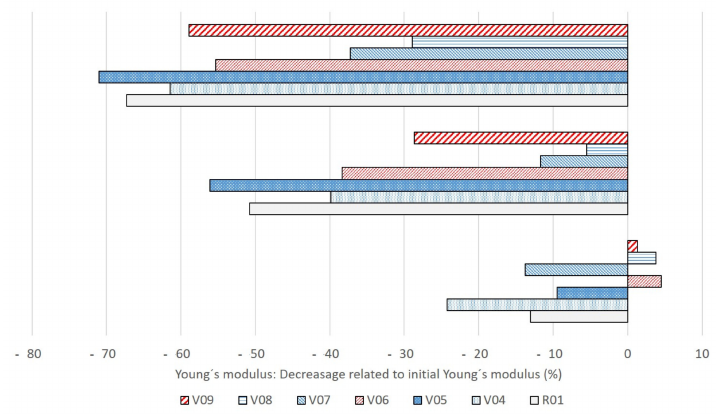
Figure 6. Percentage in loss of Young’s modulus of PLA/PBS-based blend systems (7:3) after 1, 2 and 3 weeks of storage under industrial composting conditions. Compositions: R01: unfilled reference; V04/V07: plus 5/15 phr coarse talc; V05/V08: plus 5/15 phr fine talc; V06/V09: plus 5/15 phr